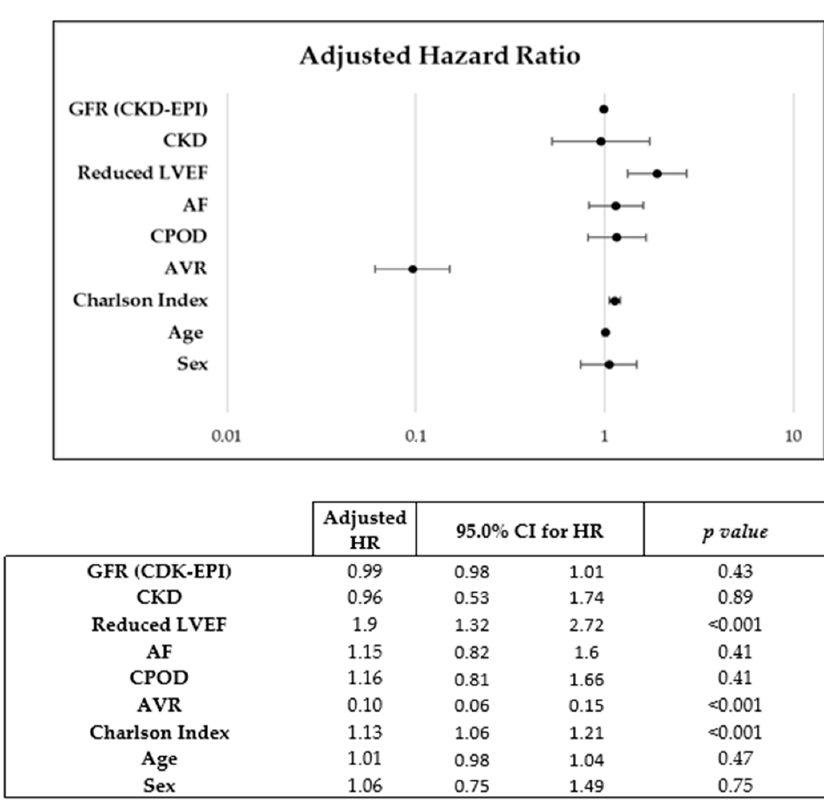
Figure 2. Cox regression used for multivariate analysis of predictors of cardiovascular mortality. Patients with AVR had higher survival rates than with medical treatment (HR: 0.08 [0.05–0.13]; p < 0.001). No significant differences in cardiovascular mortality were observed between the genders in the function of the treatment received: conservative treatment (log-rank p = 0.93) versus AVR (log-rank p = 0.42) (Figure 3C). Long-term prognosis after surgical AVR (log-rank p = 0.24) (Figure 4A) versus TAVR (log-rank p = 0.81) also did not differ significantly between women and men (Figure 4B).